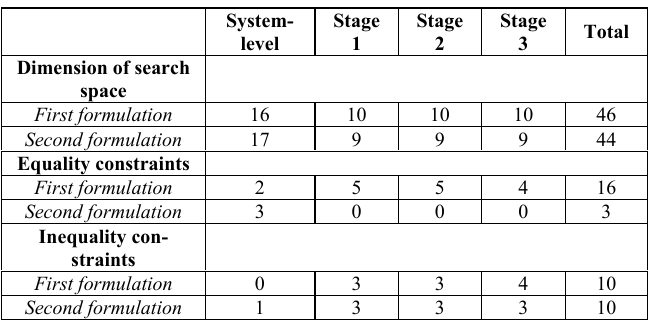
Table 5. Comparison of stage-wise decomposition formula-